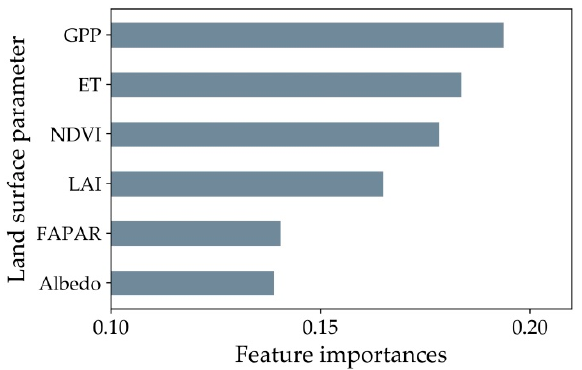
Figure 5. Feature importance of 6 quantitative remote sensing features such as albedo, ET, FAPAR, GPP, LAI and NDVI obtained through random forest.